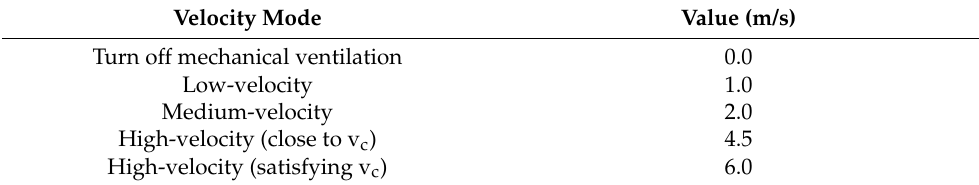
Table 1. Different velocity modes and values in tunnel fire.